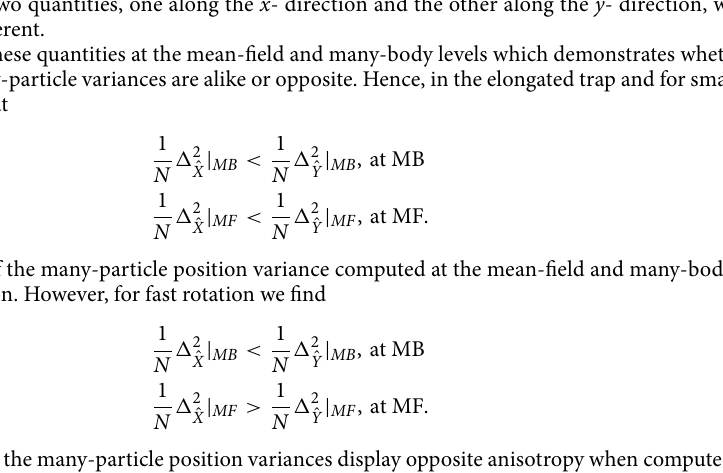
Figure 5. Dependence of the the many-particle position and momentum variances on the rotation in the elongated trap. Shown are ( a ) 1 N (cid:31) 2 ˆ X , ( b ) 1 N (cid:31) 2 ˆ Y , ( c ) 1 N (cid:31) 2 ˆ P level (MB) [ M = 4 self-consistent orbitals] and at the mean-field level (MF) [ M = 1 self-consistent orbital]. All quantities shown are